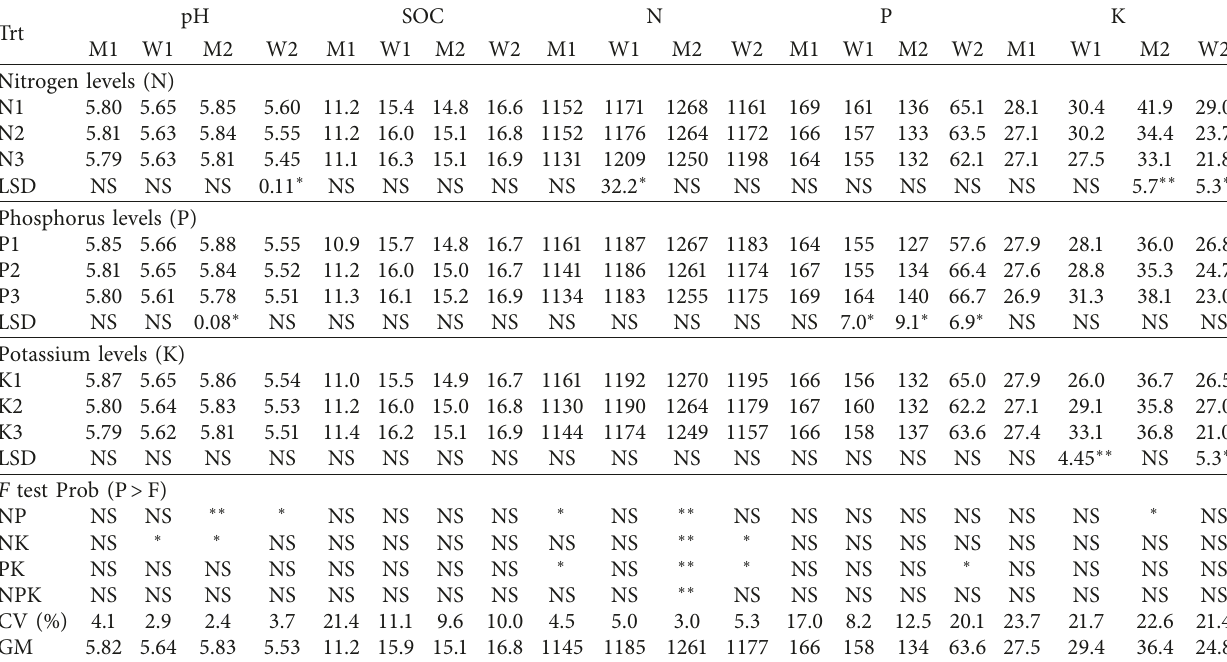
Table 6: Effects of different NPK rates on pH, organic carbon (g/kg), total nitrogen (mg/kg), available phosphorus (P available potassium (K 2 O, mg/kg) over different seasons at Khumaltar,